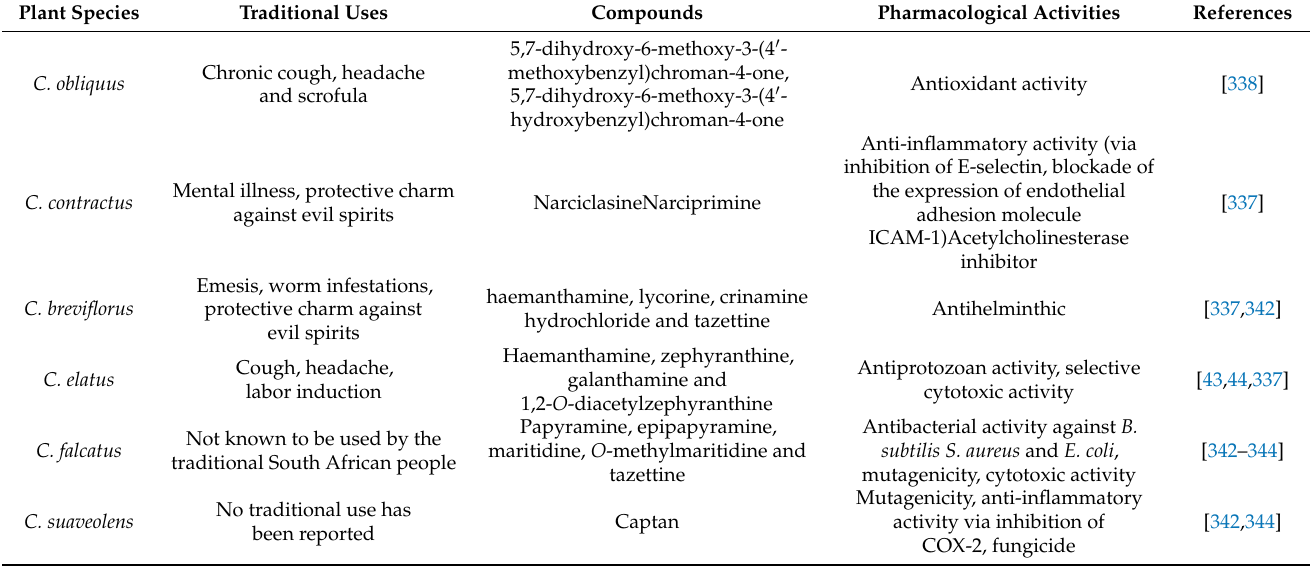
Table 13. A summary of the traditional uses, phytochemicals and pharmacological activities of Cyrtanthus